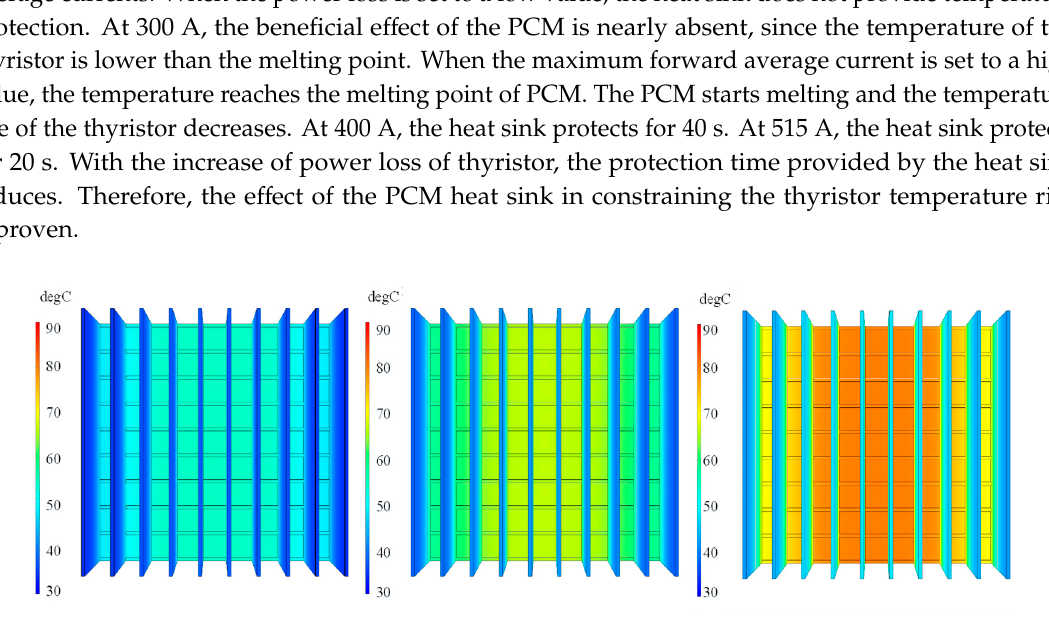
Figure 5. The temperature changes of the center of the thyristor under three maximum forward average current. The power loss significantly affects the temperature protection time of the heat sink. It should be noted that the PCM will not melt when the maximum forward average current is lower than 300 A. Hence, the power loss of thyristor should be taken into consideration in designing PCM heat sinks for thyristors. Besides this, the time of temperature protection should be much longer than the time of failure removing. 4.2. Effects of Air Velocity It is assumed that the maximum forward average currents of the thyristor are 515 A and 0 A, and the initial temperatures of this model are 30 °C and 100 °C, respectively. The effects of air velocity on the PCM heat sink were studied. In this case, the air velocities are set to 0.1 m/s, 0.5 m/s, 1 m/s, and 3 m/s. According to Equations (2) and (3), the equivalent convective heat transfer coefficients are 5.03 W/mK, 14.3 W/mK, 22.6 W/mK, and 46.7 W/mK. Figure 6a shows the time-temperature curves for four different air velocities under the full load of the thyristor. When the air velocities are set to 0.1 m/s, 0.5 m/s, and 1 m/s, the protection times provided by the PCM heat sink are 28 s, 85 s, and 120 s, respectively. As the air velocity increases, the time required for the PCM to melt increases gradually. The heat absorbed by the PCM is determined by the mass quality, latent heat, and the time of melting. Effective protection requires a short melting time. When the air velocity is 0.1 m/s, the heat sink has the best thermal performance during the melting process. It should be noted that, if the air velocity is 3 m/s, the temperature of the heat sink can not reach the melting point of the PCM and the protection of the heat sink will not work. The 0